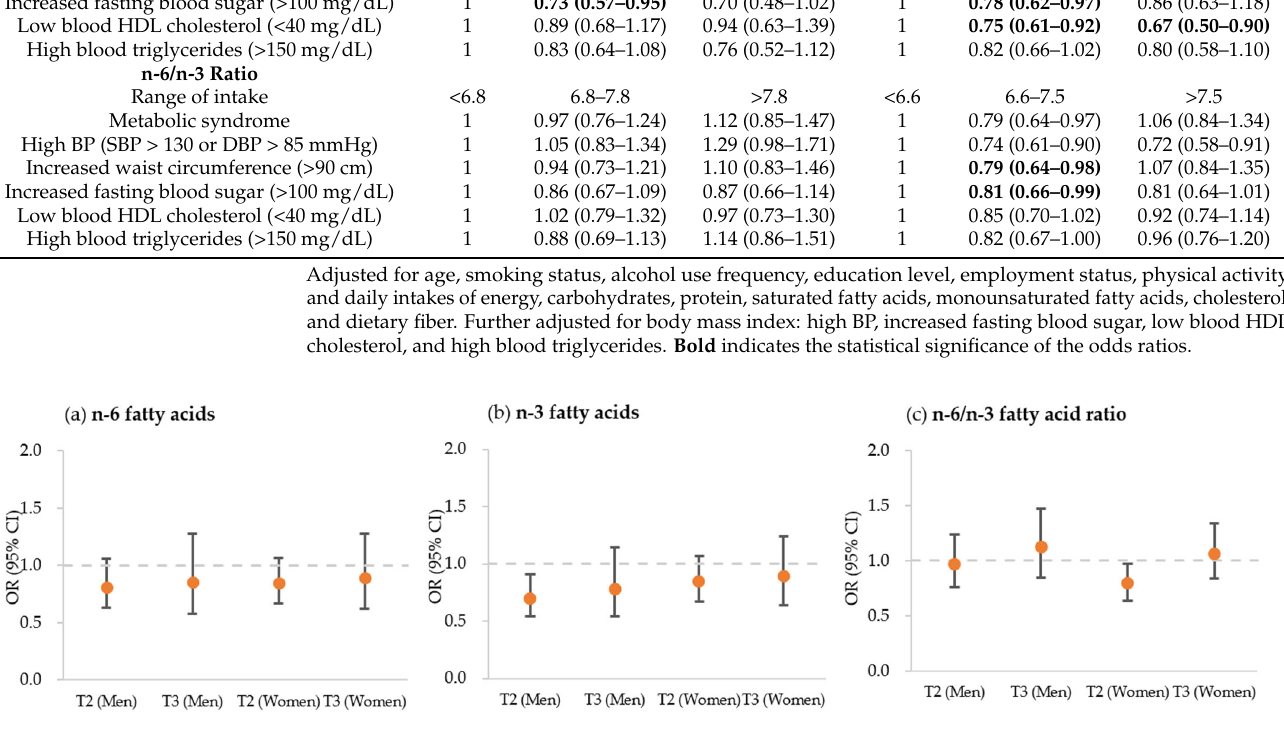
with HbA1c and also categorized into a tertile group. They were compared to the presence of metabolic syndrome, and ORs were calculated. Table 3. Multivariate ‐ adjusted odds ratios and 95% confidence intervals for the interactions be ‐ tween MetS and HbA1c groups according to n ‐ 3 and n ‐ 6 fatty acid intakes and gender for Korean participants. Odds Ratio—HbA1c 1/3 (<5.4) Odds Ratio—HbA1c 2/3 (5.4— 5.7) Odds Ratio—HbA1c 3/3 (>5.7) Tertiles of PUFA Intake Tertiles of PUFA Intake